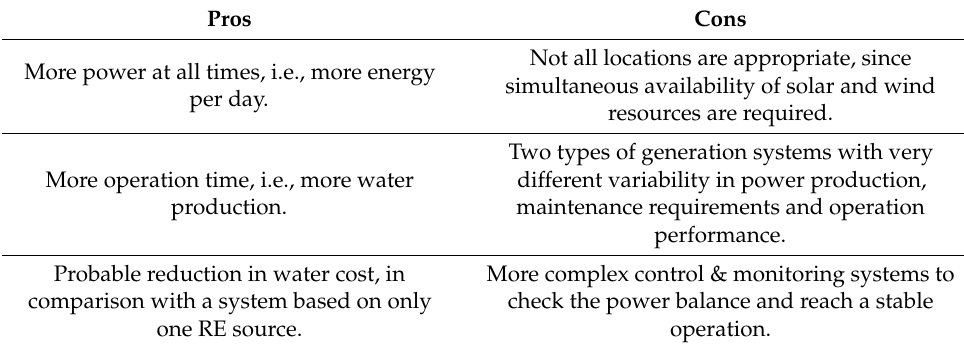
Table 11. Main data of two selected hybrid PV/wind-driven SWRO systems. Location PV